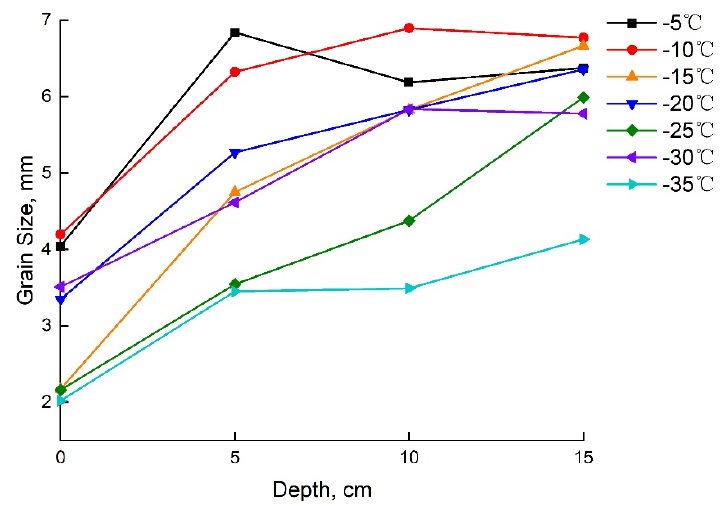
Figure 10. Grain size vs. depth curves of distilled water ice grown at different temperatures.